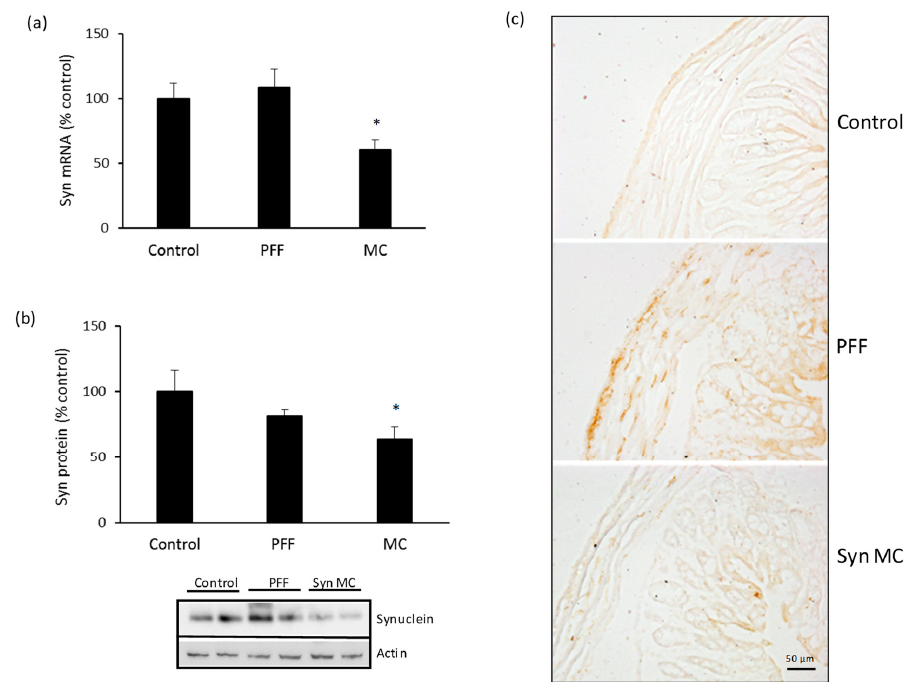
Figure 3. Alpha-synuclein downregulation in intestine of mice treated with anti-alpha-synuclein shRNA-MC RVG-EV. Analyses of alpha-synuclein mRNA expression ( a ) and protein levels ( b ) nor- malized to actin. Typical western blot is shown. ( c ) Intestine sections were stained for S129 phospho- synuclein, typical immunohistochemical images are shown. Scale bar represents 50 µm. Values are expressed as mean ± SEM ( n = 5). * p < 0.05, non-parametric Kruskal–Wallis test.